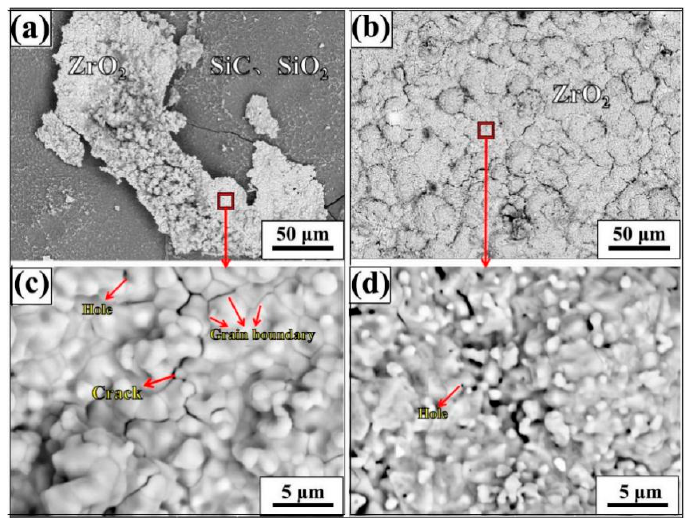
Figure 7. The surface morphology of ablated ZrC/SiC coating ( a , c ) and ZrC-SiC coating ( b , d ) at central ablation region.